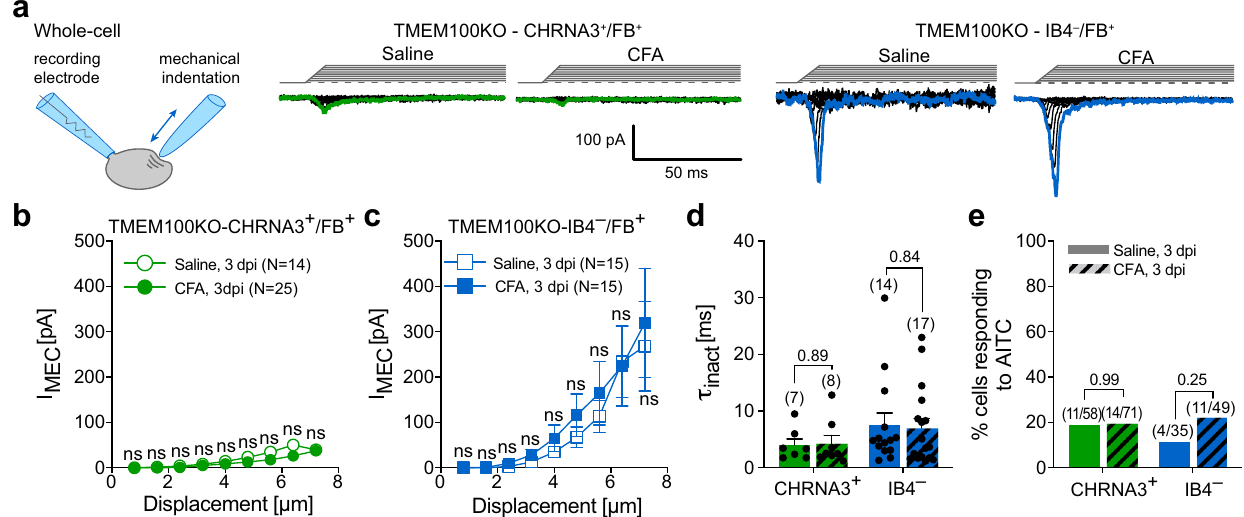
Fig. 5 | CFA-induced knee joint in fl ammation fails to sensitize CHRNA3-EGFP + neurons to mechanical stimuli in TMEM100 knock-out mice. a Cartoon depicting the mechano-clamp con fi guration of the patch clamp technique (left, originally published in Verkest et al. https://doi.org/10.1038/s41467-022-28974-6 NatCommun)andexampletracesofmechanically-evokedcurrentsintheindicated cell types and conditions (right). Note, in contrast to WT mice, CHRNA3-EGFP + neurons from TMEM100KO mice do not acquire mechanosensitivity during CFA- induced in fl ammation. b, c mean±SEM peak amplitudes of mechanically-evoked currents are shown as a function of membrane displacement for b MIAs and c peptidergic nociceptors from saline (open symbols) and CFA-treated (solid symbols)mice.Currentamplitudeswerecomparedusingtwo-sidedMann-Whitney test ( P -values for b from left to right: ns=0.99, ns=0.45, ns=0.21, ns=0.57, ns=